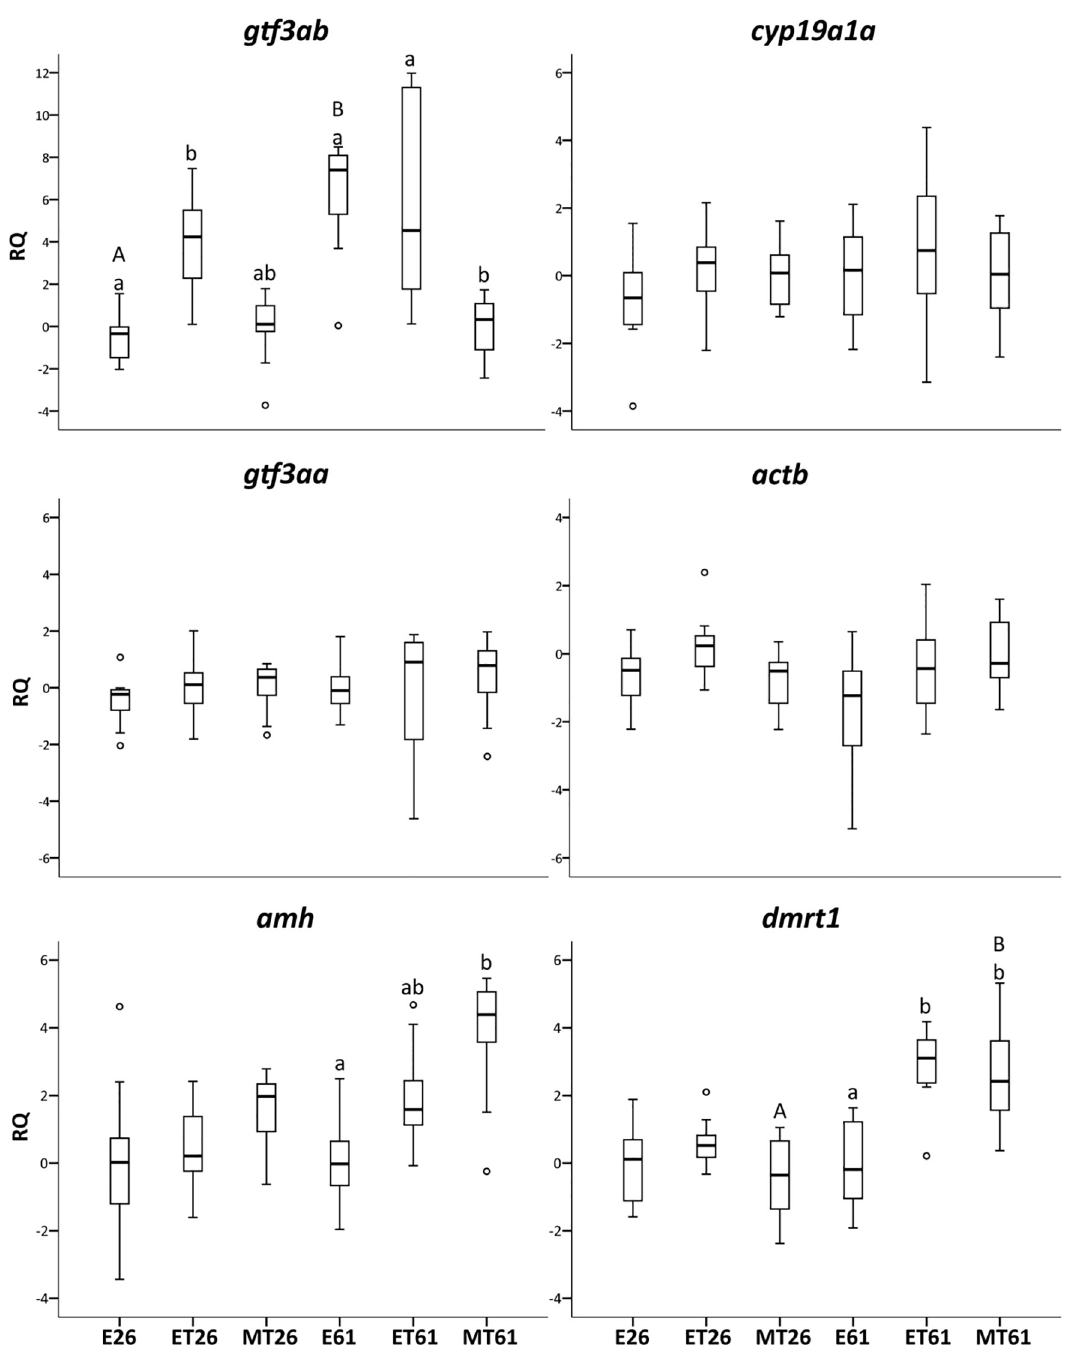
Fig 5. Transcription levels of sex related genes in zebrafish exposed to hormones for 26 and 61 days. Fish exposed to 17 β -estradiol (E) and 17 α -methyltestosterone (MT) for 26 and 61 days (E26, E61 and MT26, MT61). Ethanol control group at 26 and 61 days (ET26 and ET61). Box plots represent the data within the 25th and 75th percentiles, with the median indicated by a line, and top and bottom whiskers indicating the minimum and maximum values (n = 12 individuals per experimental group). Different lower case letters indicate significant differences between groups within each sampling day and different capital letters indicate significant differences within each exposure group either comparing days 26 and 61 (Kruskal-Wallis, p < 0.05).